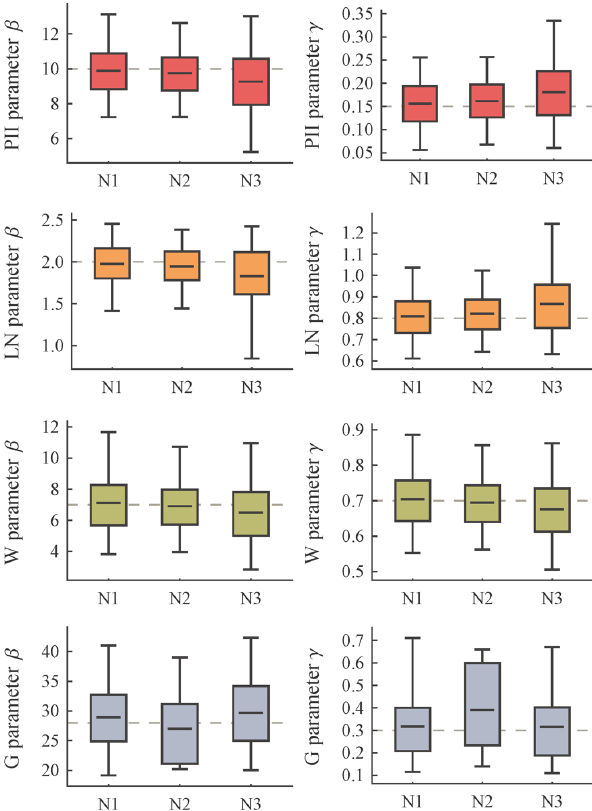
Fig. 9. Results of a Monte Carlo scheme implemented to evaluate the performance of the norm N1 used in fitting of tails in this study, in comparison to commonly used ones (N2, N3).